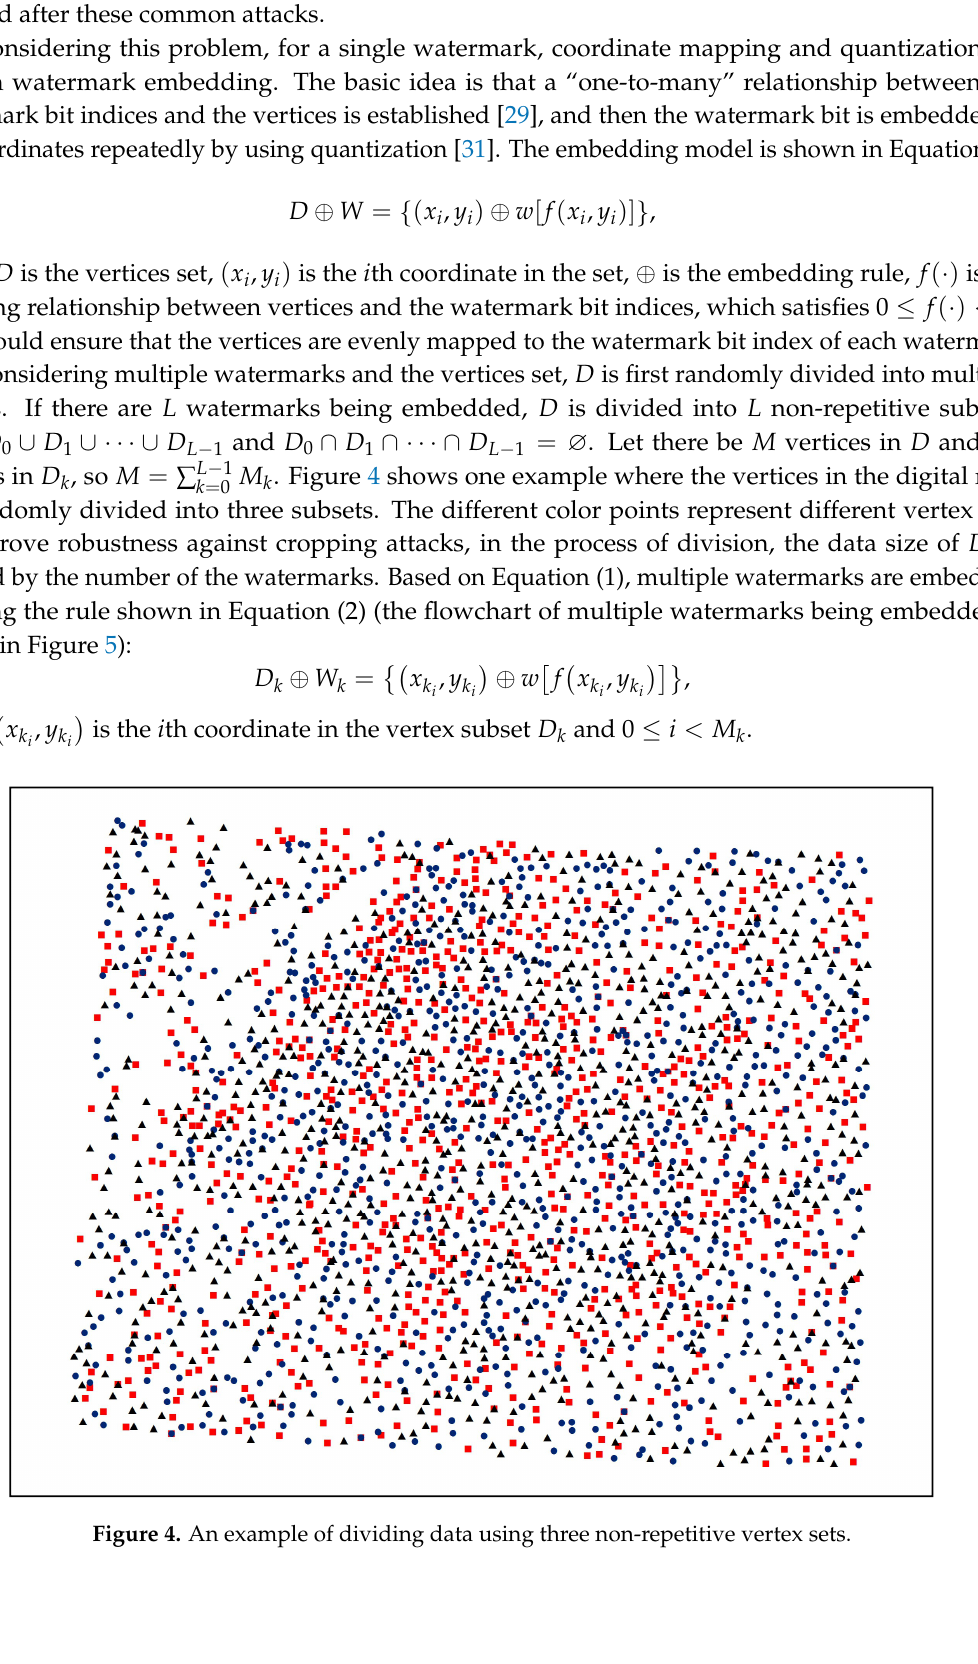
Figure 5. The flowchart of multiple watermark embedding. unidrnd( 𝐿 ) returns random numbers chosen uniformly from the set {1,2,3,⋯,L} . 2.3. Watermark Extraction and Detection 2.3.1. Watermark Extraction Detection of a meaningless watermark concludes the process of watermark extraction and detection. In watermark extraction, the watermark bit sets are extracted from the data. The flowchart of multiple watermark extraction and detection is presented in Figure 6.